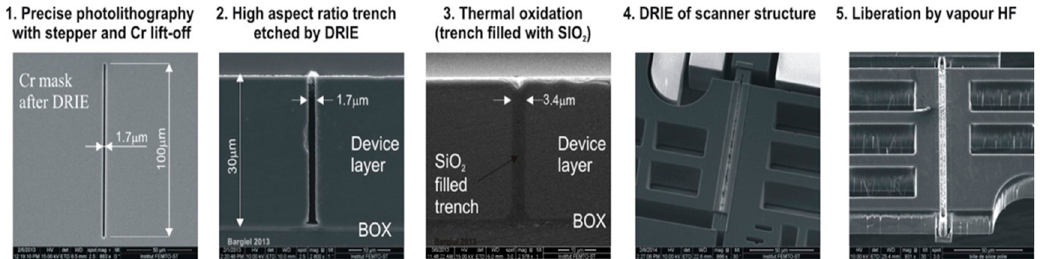
Figure 12. Fabrication steps of the vertical insulation trenches.